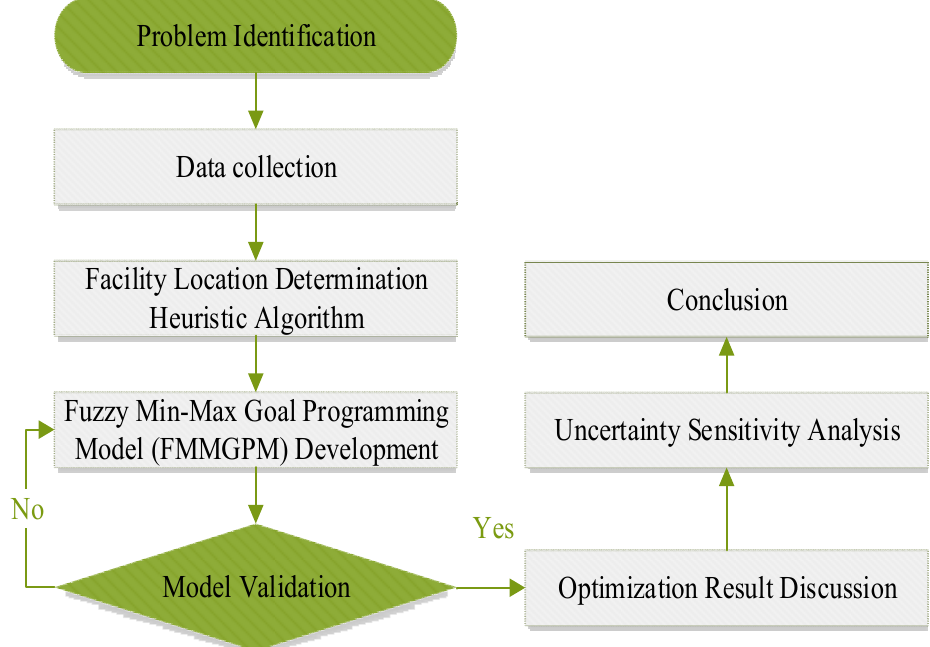
Figure 2. Proposed methodology.